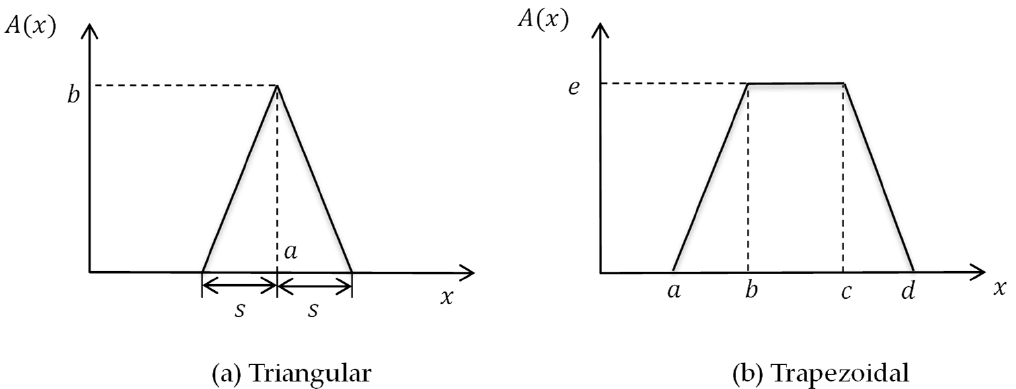
Figure 3. Membership functions: ( a ) Triangular and ( b ) Trapezoidal.